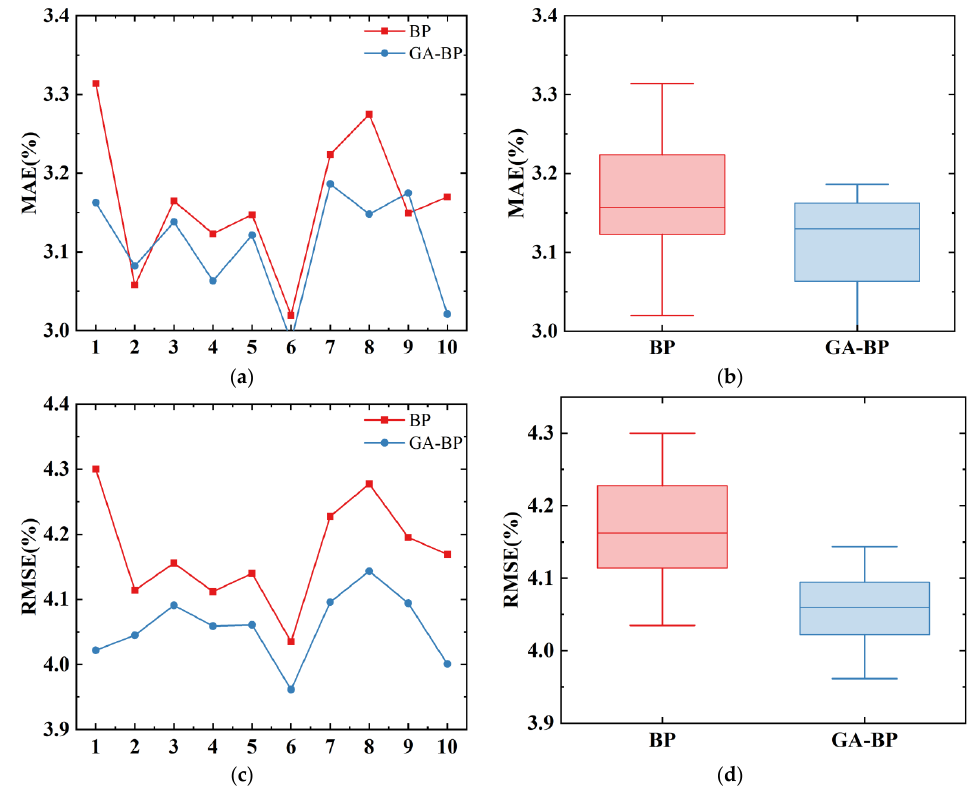
Figure 9. The prediction results of five test groups for slip_ x using BP and GA-BP: ( a ) the line charts of MAE; ( b ) the boxplots of MAE; ( c ) the line charts of RMSE; ( d ) the boxplots of RMSE.